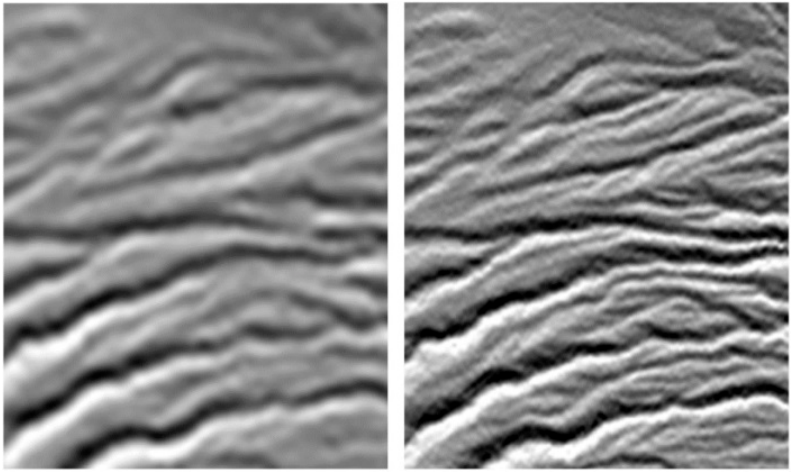
Figure 14. Visual comparison between hillshaded SRTM 3” ( left ) and SRTM 1” ( right ) DEMs displayed on NASA website to promote the new 1” product.